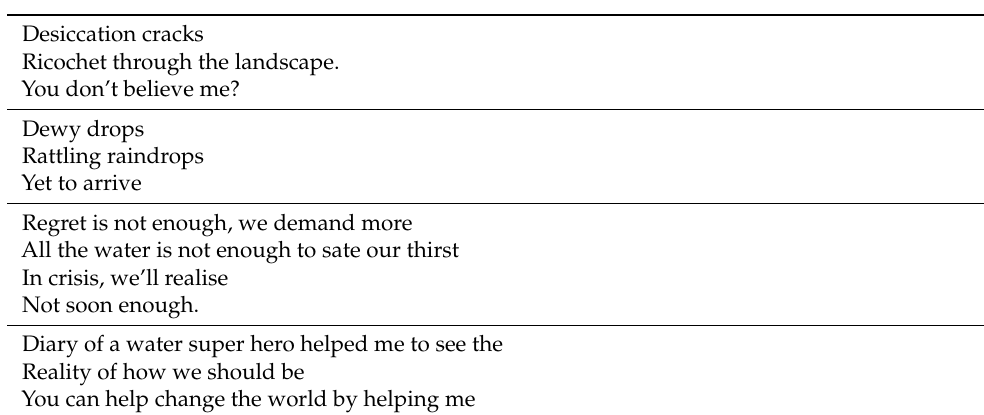
Table 2. Cont. Desiccation